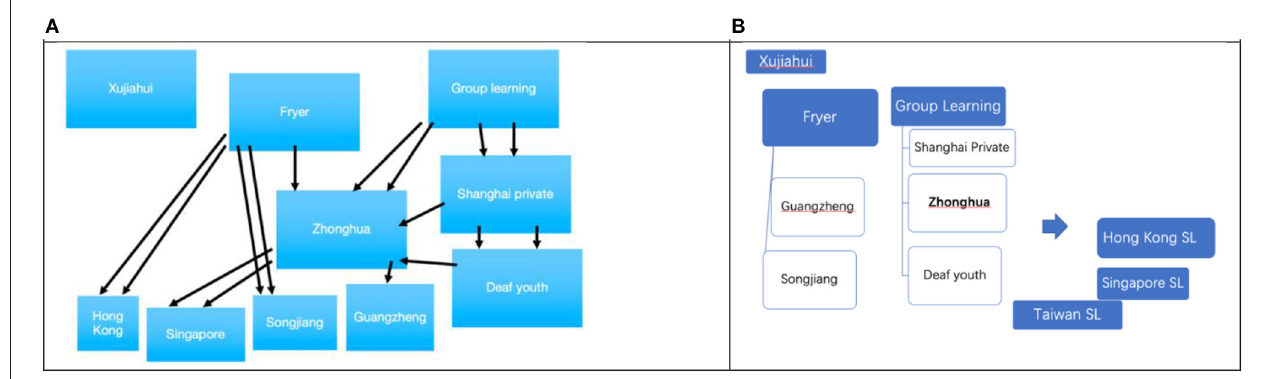
FIGURE 5 | (A) Generic relationship within SCSL*. (B) SCSL relationship with its neighboring sign languages. *One arrow means deaf students or teachers work in descending school, double arrows show the stronger relation that deaf students or teachers are the founders of the deaf schools to which the arrows are directed.